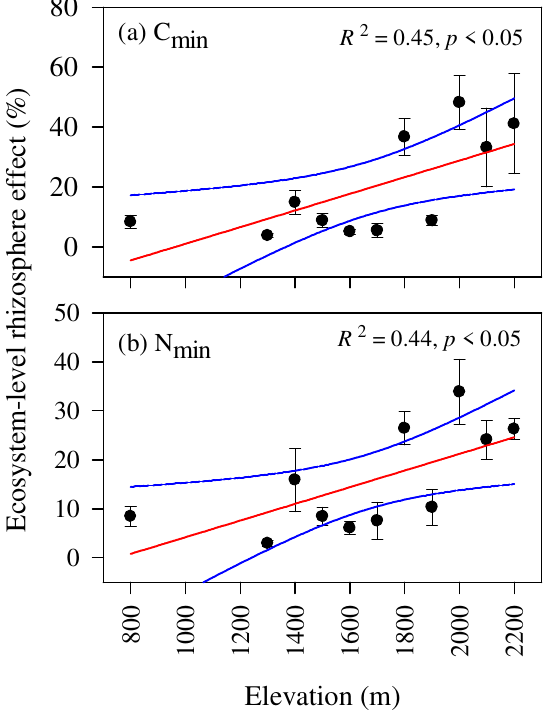
Figure 6. Relationship of the rhizosphere effects on soil carbon mineralization rate (C min , ( a )) and soil nitrogen mineralization rate (N min , ( b )) with elevation ( n = 11). The solid red lines represent linear regression, and the blue lines represent the 95% confidence intervals.